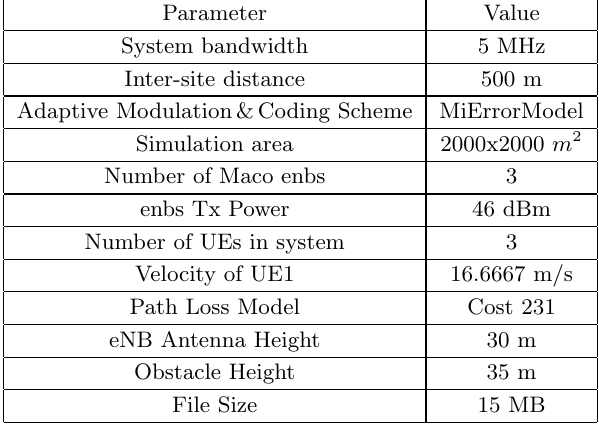
Table 1: Simulation Parameters